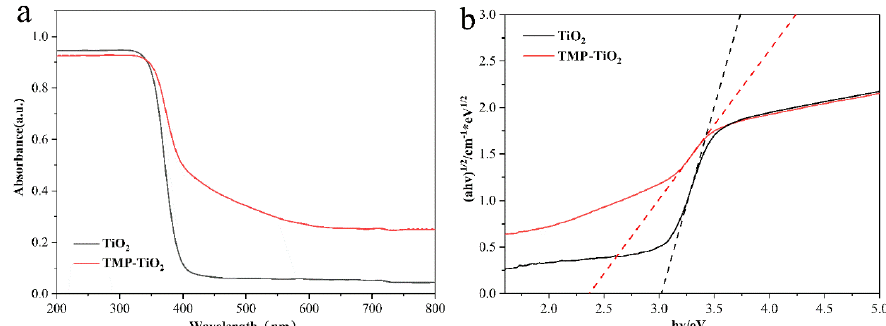
Figure 8. ( a ) UV-Vis DRS of TiO 2 and TMP-TiO 2 , and ( b ) plots of transformed Kubelka-Munk function versus the energy of absorbed light.